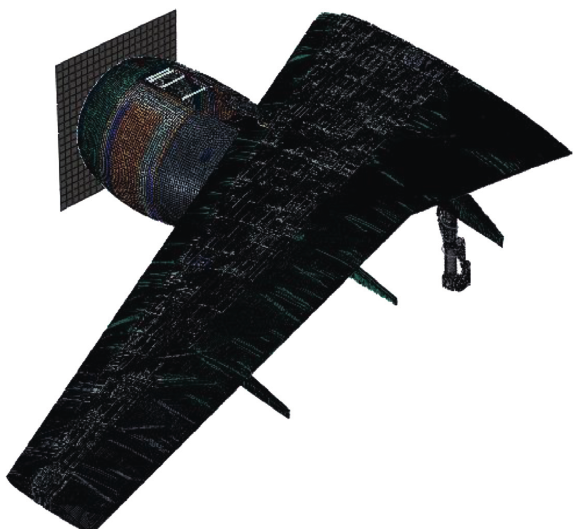
Figure 27: Course impact model of crash with wheels retracted.